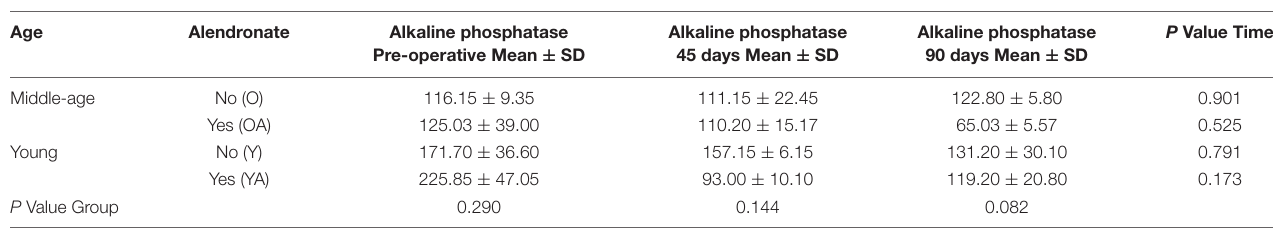
TABLE 2 | Serum levels of alkaline phosphatase in the groups at different times.